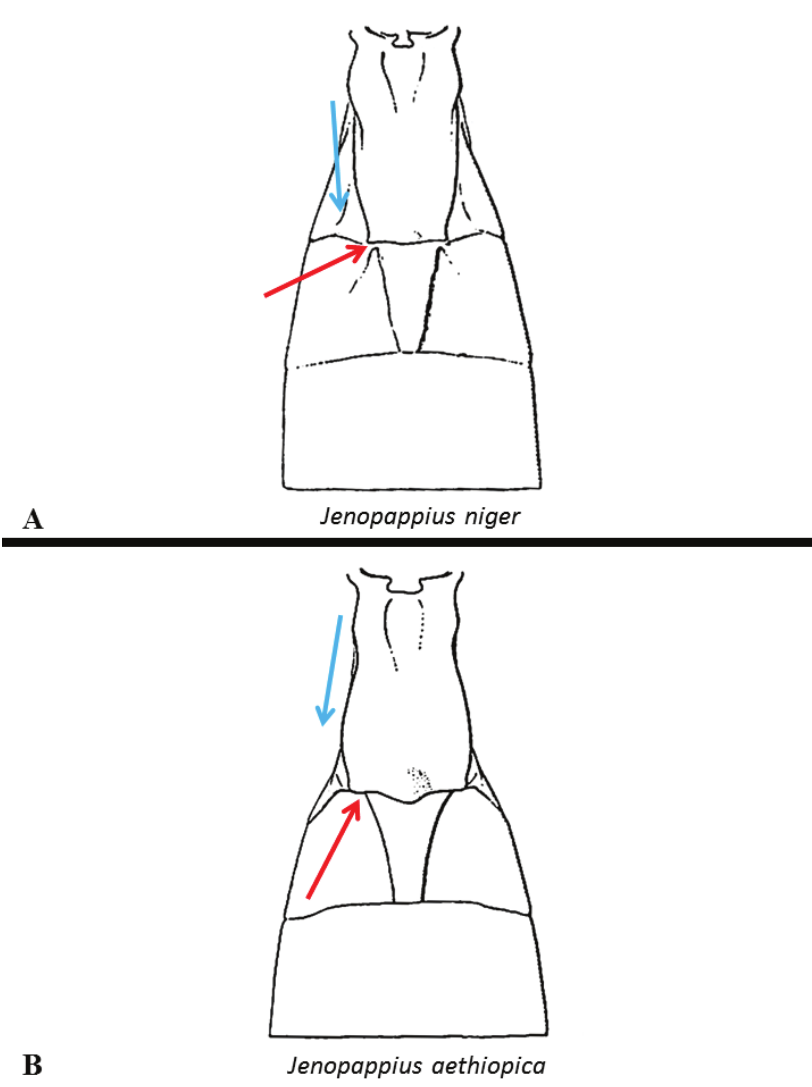
Figure 19. Comparison of tergites 1 and 2 in Jenopappius niger ( A ) and Jenopappius aethiopica ( B ) based on modified drawings from the original descriptions of the species (de Saeger 1944). Blue ar- row shows tergite 1 narrowing ( A ) or widening ( B ) towards posterior margin. Red arrow shows end of lateral margin of tergite 1 and beginning of lateral margin of median area of tergite 2 to be almost continuous ( A ) or end of lateral margin of tergite 1 and beginning of lateral margin of median area of tergite 2 to be clearly separate ( B